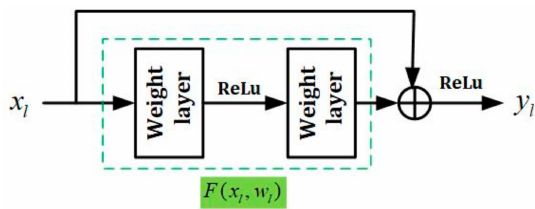
Figure 1. The structure of the residual unit.